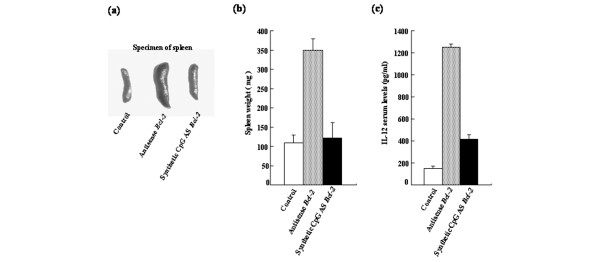
Effect of antisense Bcl-2 oligodeoxynucleotides on splenomegaly development and serum IL-12 levels in athymic mice. (a) Segment of spleen from a mouse with splenomegaly after treatment with antisense (AS) Bcl-2 oligodeoxynucleotides (ODNs), and segments from untreated (control) and synthetic CpG AS Bcl-2 ODN-treated mice. (b) Comparison of splenic weight among mice treated with AS Bcl-2 ODNs, synthetic CpG AS Bcl-2 ODNs, and control mice. (c) Increased serum levels of IL-12 were observed in mice treated with AS Bcl-2 ODNs, compared with those treated with synthetic CpG AS Bcl-2 ODNs, and with control mice. Each point represents the mean of the three mice in each group. Error bars indicate SD. The data presented are from three independent experiments.